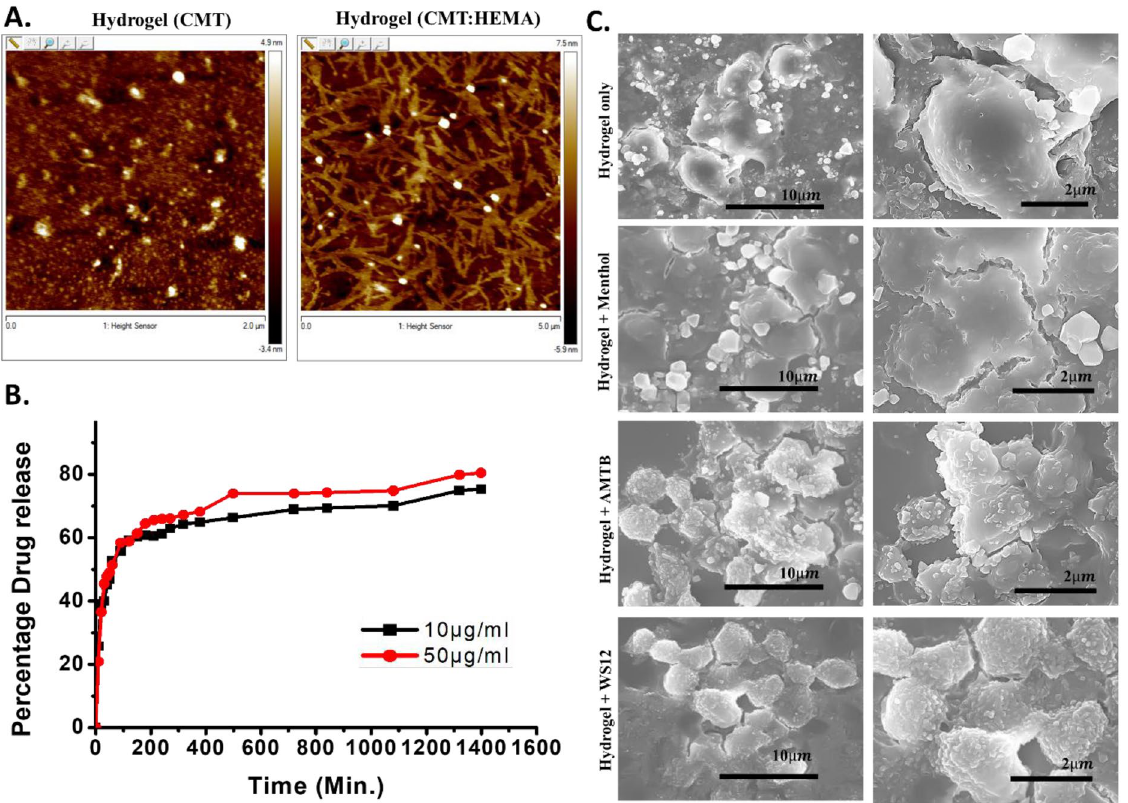
Figure 3. Hydrogel (CMT:HEMA) as a suitable surface for drug coating and growing of Mesenchymal Stem Cells. (a) Shown are the Atomic Force Microscopic images of CMT only and CMT:HEMA. CMT:HEMA provides a surface with optimum network and stiffness suitable for growth of Mesenchymal Stem Cells. C-0 corresponds to pure carboxymethyl tamarind while C-10 corresponds to Hydroxyethylmethacrylate incorporated carboxymethyl tamarind hydrogel (i.e. CMT-HEMA hydrogel). ( b) Release pattern of AMTB drug from hydrogel (CMT:HEMA) are shown. ( c) Scanning Electron Microscopic images of Mesenchymal Stem Cells grown on hydrogel (CMT:HEMA) only and coated with different drugs modulating TRPM8 ion channel are shown in left side. Magnified images of same or different view field are shown in right